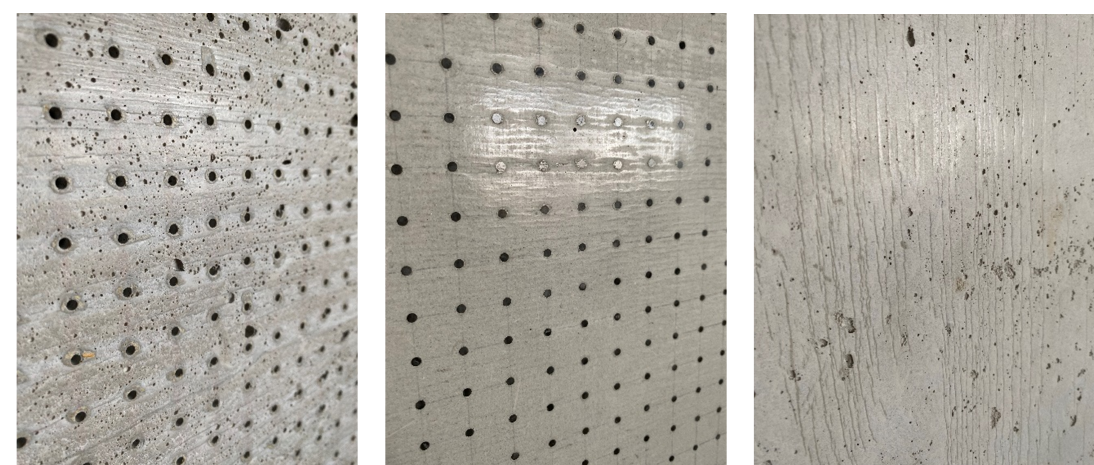
Figure 15. Examples of the surfaces of individual slabs of light-transmitting concrete.